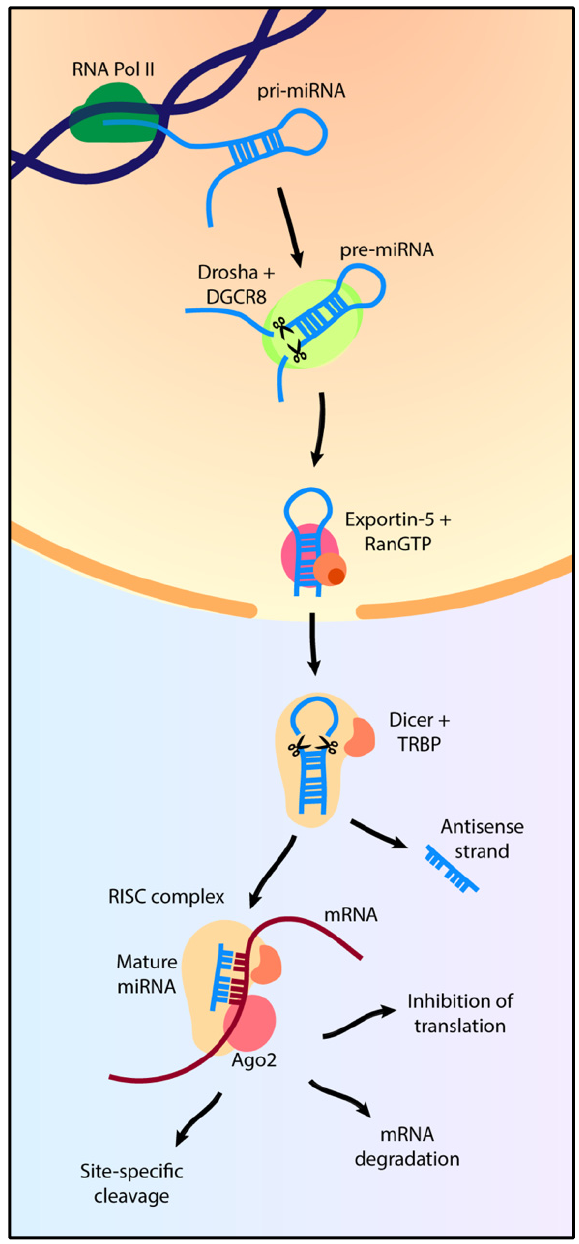
Figure 1. The canonical pathway of miRNA biogenesis.